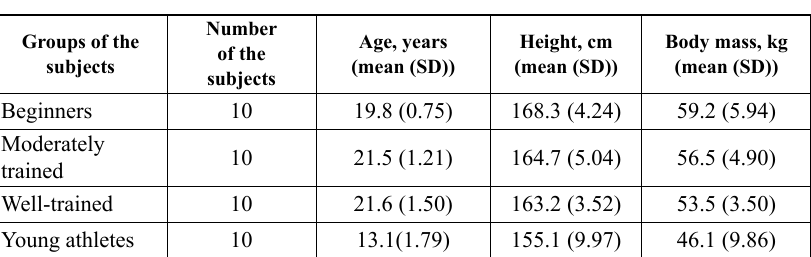
Table 1. Anthropometric charac- teristics and age of aerobic